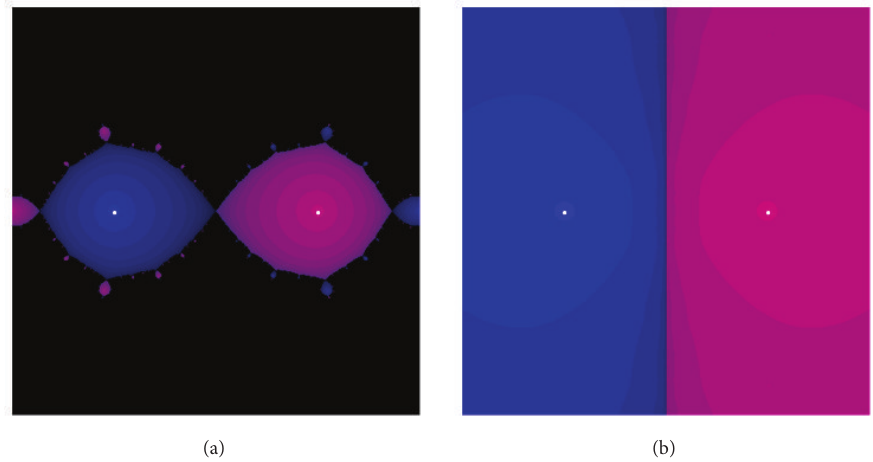
Figure 2: Attraction basins of (7) (a) and (12) (b) for the polynomial 𝑔(𝑥) = 𝑥 2 − 1